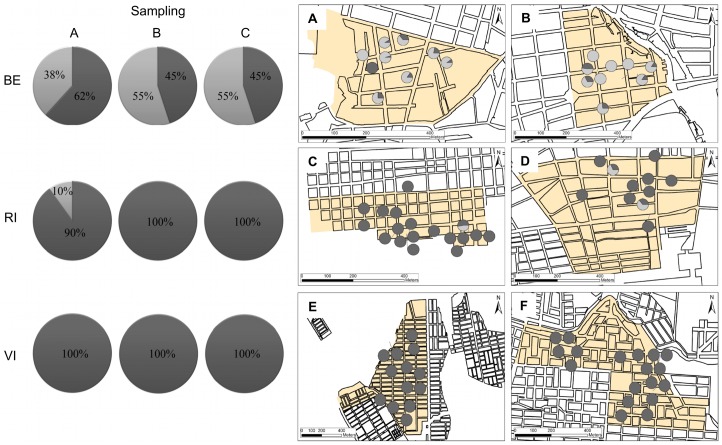
Spatiotemporal distribution of group 1 (dark gray) and group 2 (clear gray) Ae. aegypti in the cities studied.Left panel: Temporal distribution of the frequency of group 1 and group 2 of Ae. aegypti in each city. Rows represent cities and columns respective samplings A, B and C. Right panel: Spatial distribution of frequency of group 1 and group 2 Ae. aegypti across the neighborhoods of Cumbre (A) and Granjas (B) from BE; Unión (C) and Aeropuerto (D) from RI; and Porfia (E) and Popular (F) from VI.